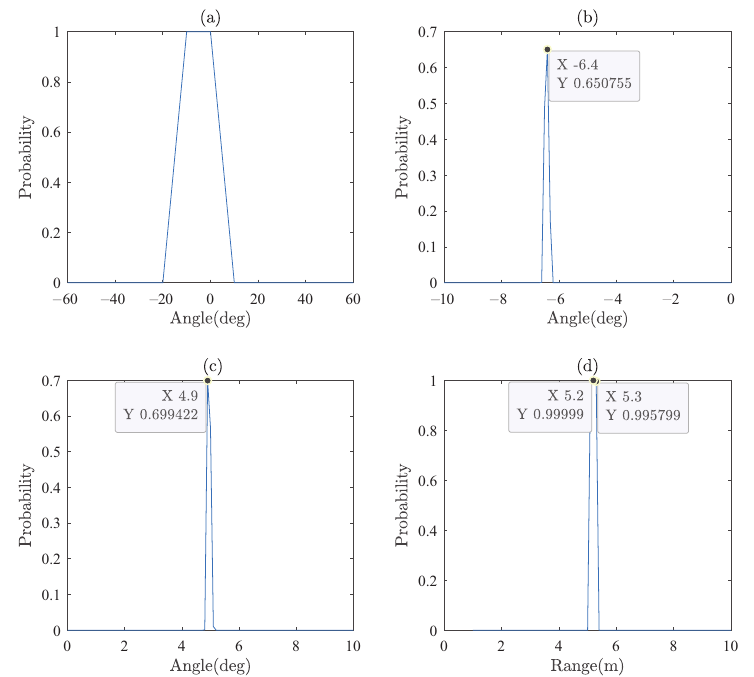
Figure 16. DOA and range estimation of Scenario